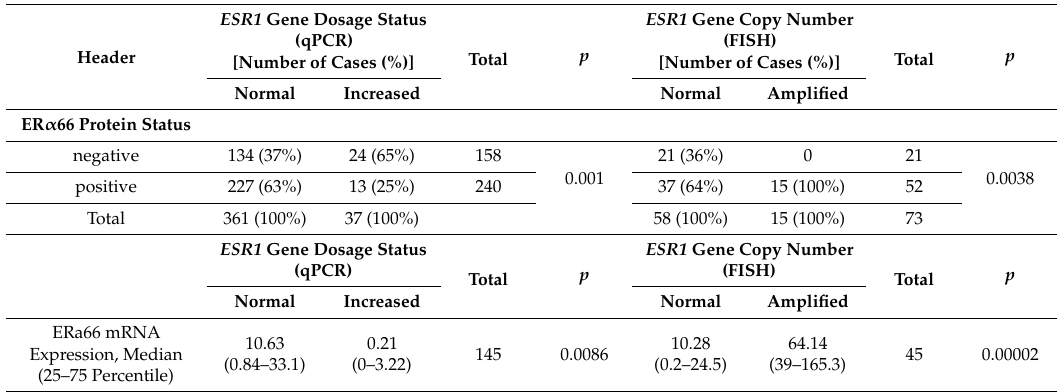
Table 1. Correlation between ER α 66 protein status, ER α 66 gene expression, and ESR1 gene status measured by qPCR or FISH.